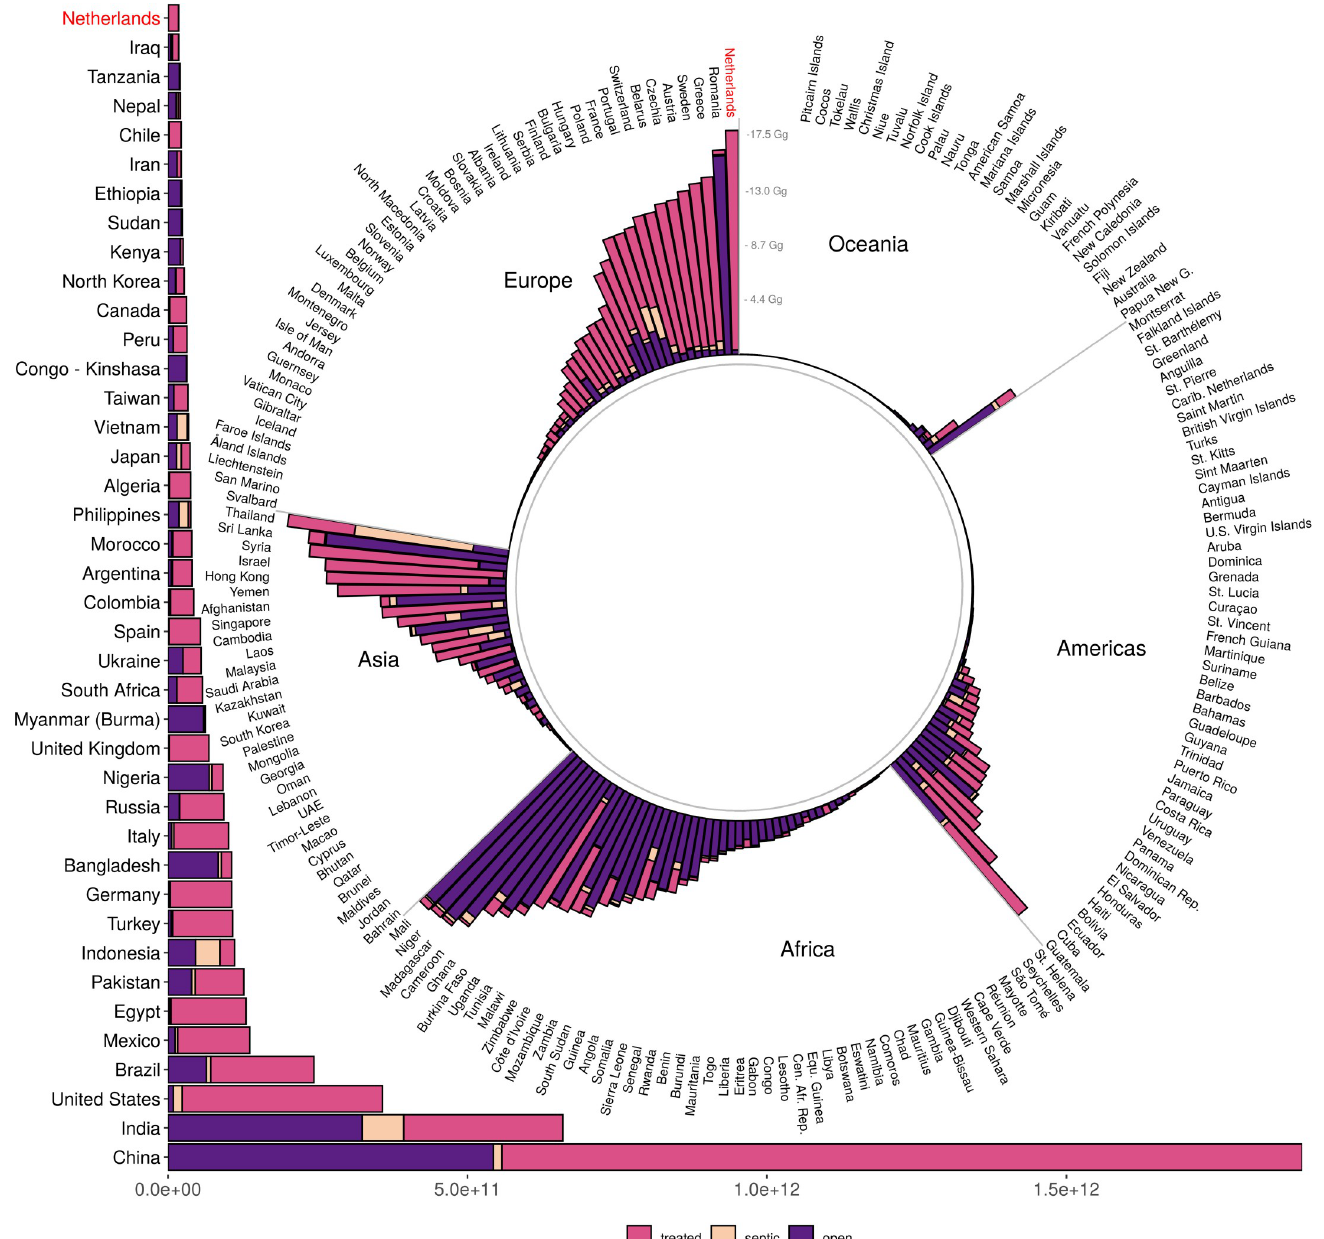
Fig 2. Total nitrogen input into Exclusive Economic Zone (EEZ) waters of coastal countries, by source type (sewer, septic, direct). The global total wastewater input is 6.2Tg N, with 3.9Tg from sewers, 0.3Tg from septic, and 2Tg from direct input. The top 40 countries are shown in the horizontal bar chart; remaining countries are in the pinwheel, grouped by continent or larger geographical region. Values for all countries are also reported in S5 Table in S1 File. Note that the Netherlands is shown in both places (in red) to help connect the scale of the two parts of the figure.